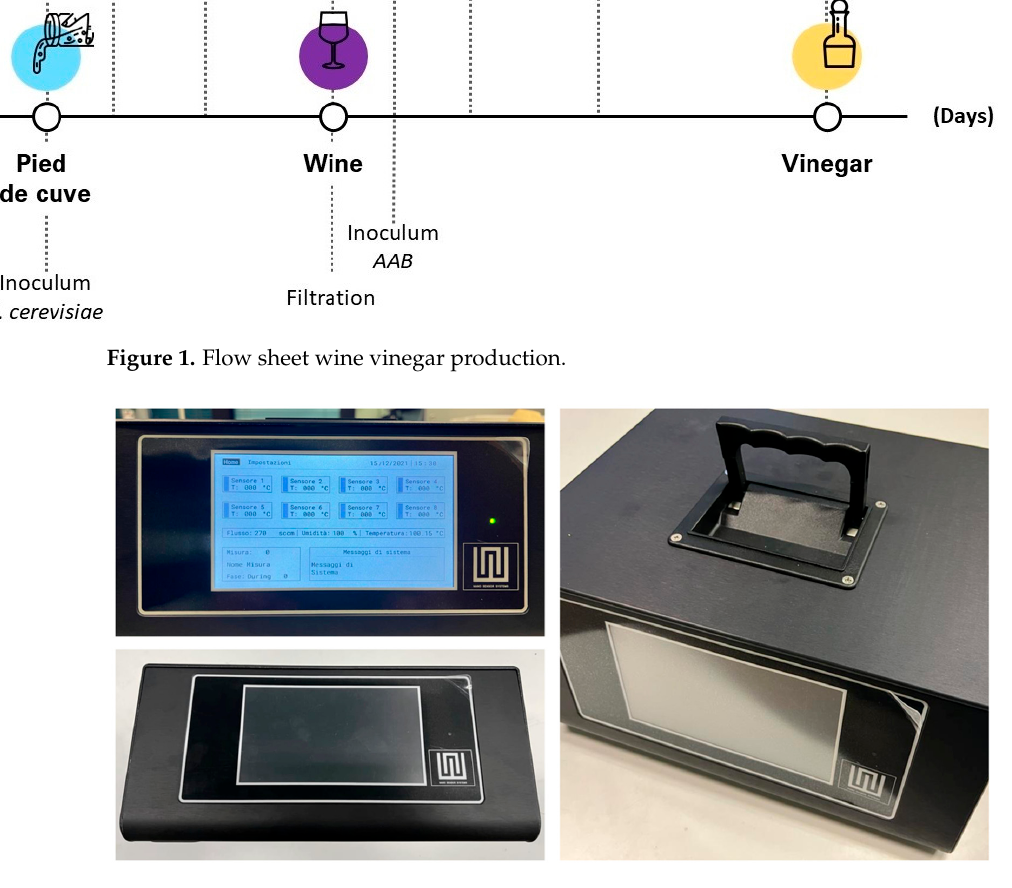
Figure 2. Small Sensory